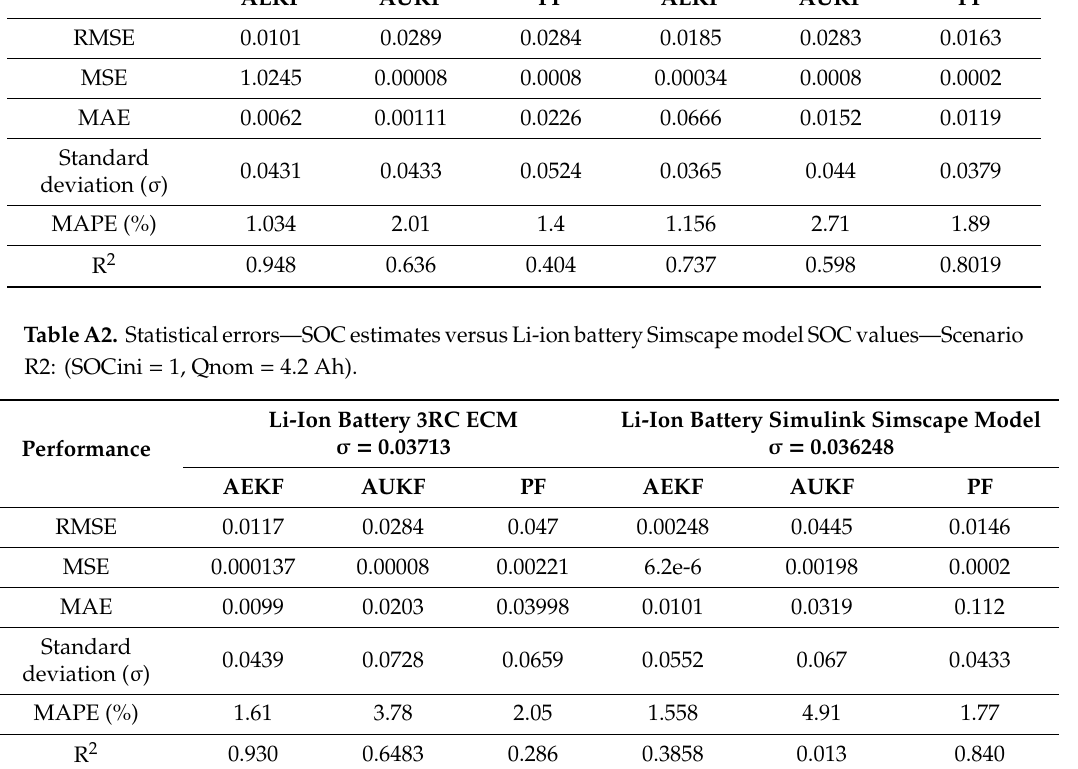
Figure A29. Robustness to simultaneous changes, SOCini = 0.4, σ noise = 0.01; ( a ) PFE SOC value versus Simscape battery model true value; ( b ) SOC residual.